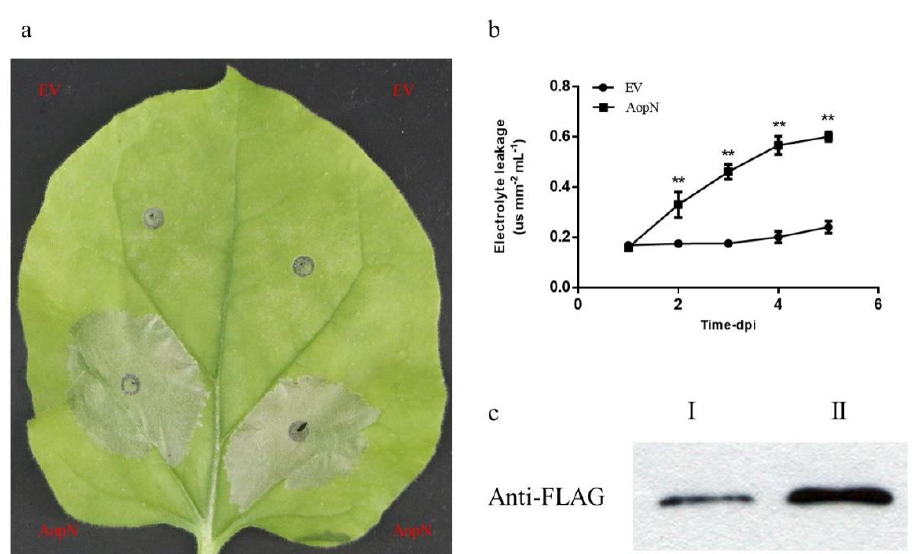
Figure 5. AopN induced program cell death (PCD) in N. benthamiana. ( a ) AopN induced PCD symptoms in N. benthamiana. The N. benthamiana leaves injected with Agrobacterium tumefaciens GV3101 strain carrying 35S: AopN-FLAG or the empty vector (EV) control were sampled 3 days after inoculation. The experiment was performed three times, with similar results obtained each time. Three independent assays were conducted and at least 10 plants with 20 different leaves were observed. ( b ) Conductivity test with AopN. The N. benthamiana leaves were injected with A. tumefaciens GV3101 strain carrying 35S: AopN-FLAG or the empty vector. Leaf disks at the injection site were removed with a puncher and placed in 5 mL sterile water in a six-well dish. After resting for 24 h, conductivity levels were measured using a conductivity meter (DDS-307, Leici Experimental Instrument Factory, Shanghai China). The experiment was performed three times, with similar results obtained each time. Data represent the means ± SD ( n = 6). ** above bars indicate significant differences as determined by t-test, p < 0.05. ( c ) Analysis of AopN protein secretion. The leaves at the injection site were collected and proteins were detected by Western blotting. I represents the 36 h sample, II represents the 48 h sample. The experiment was performed three times, with similar results obtained each time.